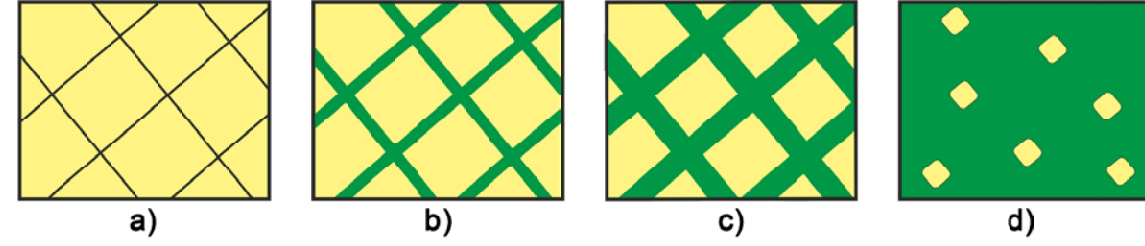
Fig. 6. Scheme of structural transformations during the transition “crystal-amorphous state” with SPD: a) fragmentation of the structure; b) formation of boundaries with an amorphous structure; c) increase in the specific volume of grain-boundary amorphous layers; d) amorphous-nanocrystalline